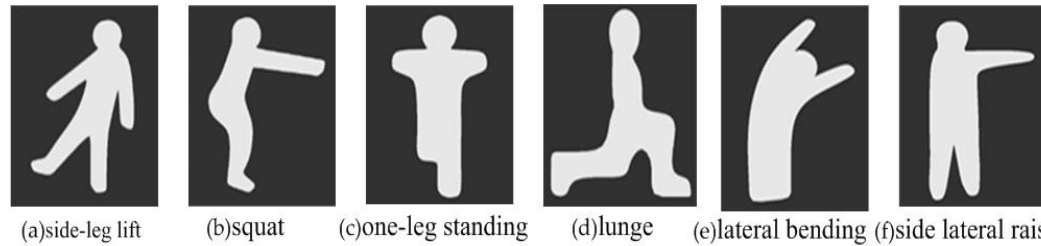
Figure 3. Shapes of the holes in the wall.